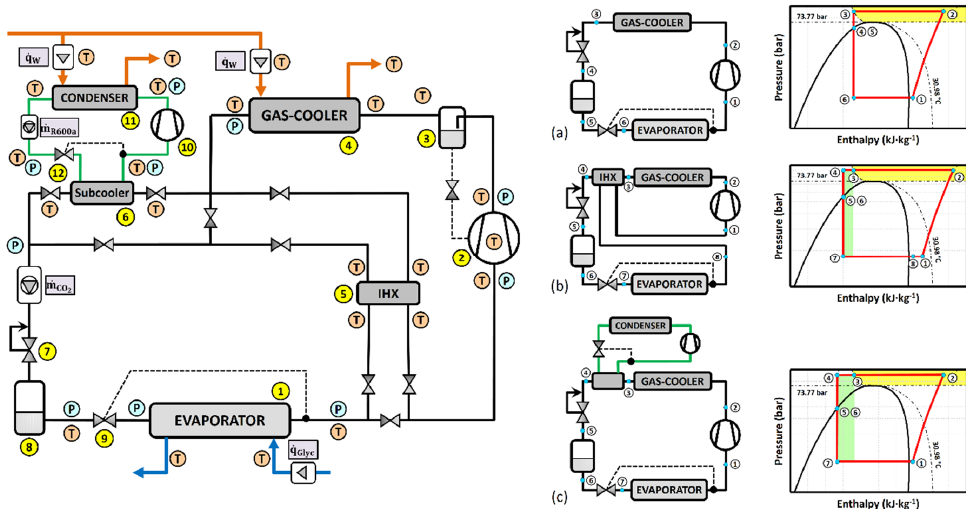
Figure 1. Schematic diagram of the experimental refrigeration plant including the analyzed configurations: ( a ) Base cycle, ( b ) IHX cycle and ( c ) MS cycle